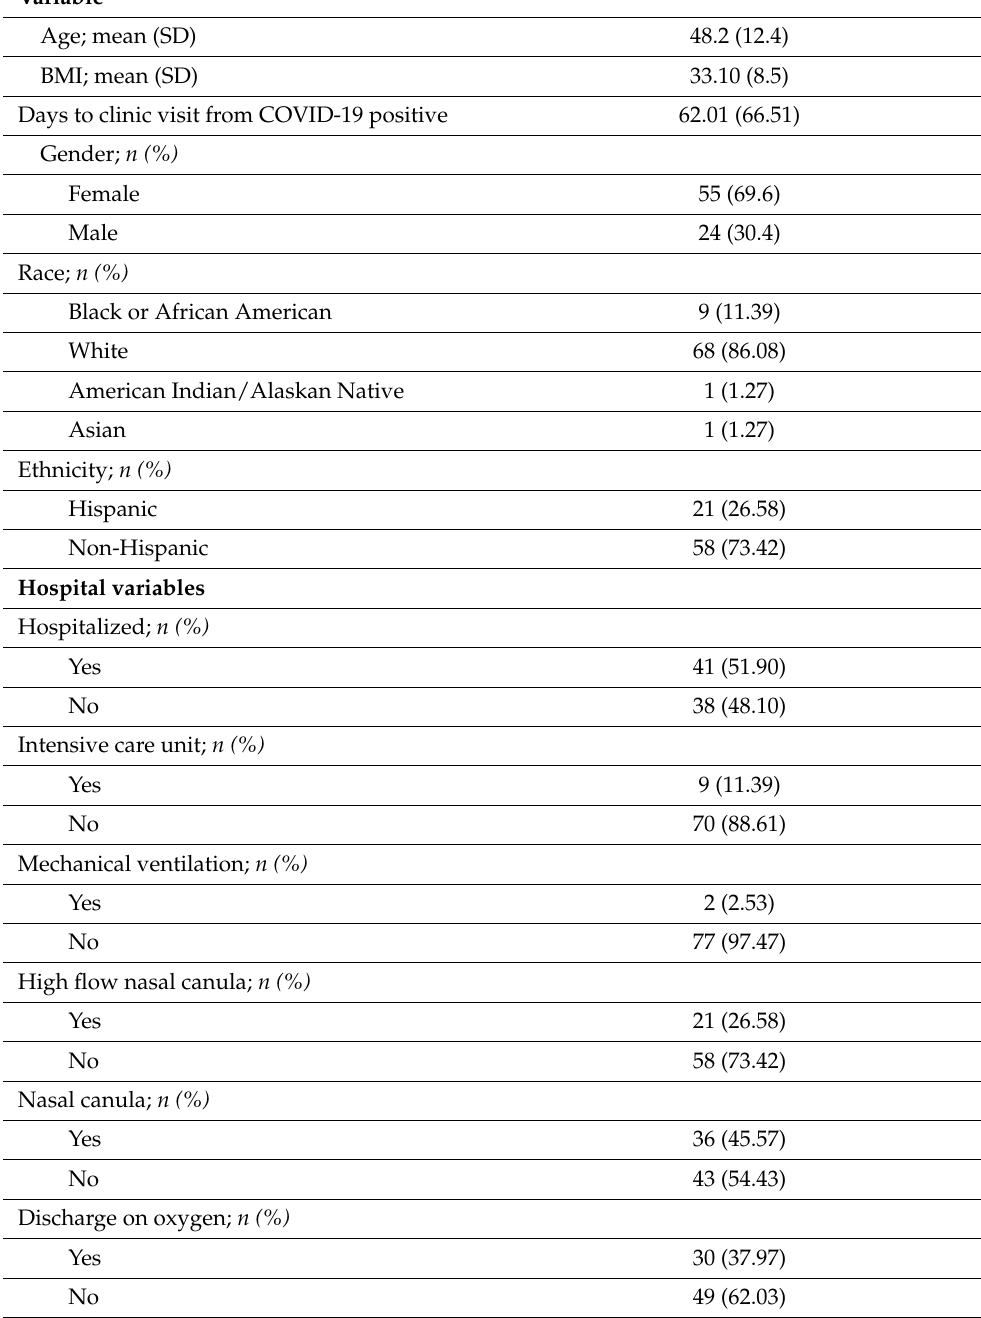
Table 1. Demographics and hospitalization characteristics of study cohort ( n =